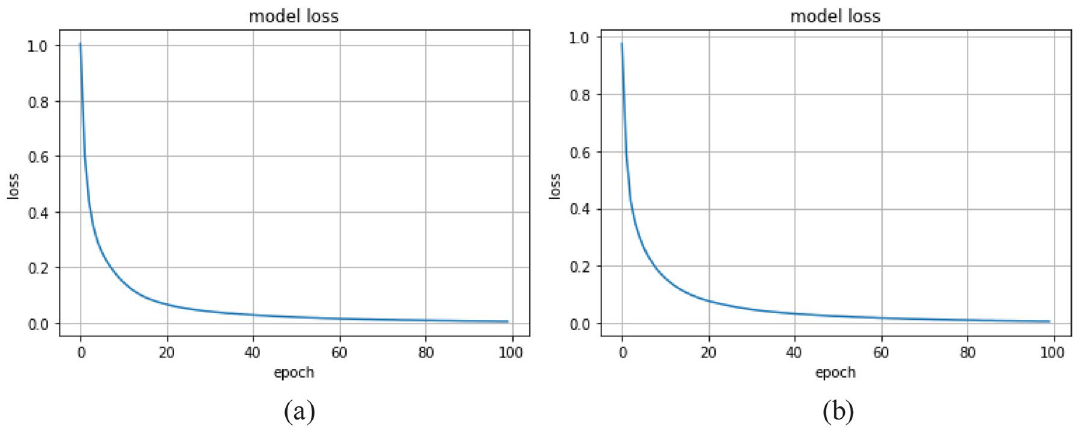
Figure 14. NSL-model error on (a) fold-1 and (b) fold-2 of PUC-Rio dataset for 100